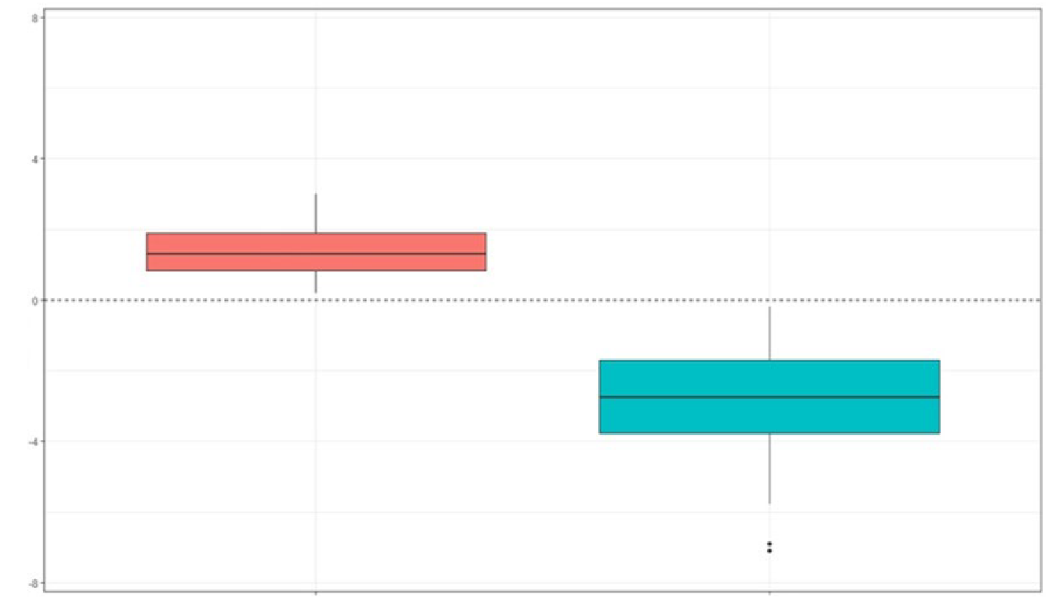
Figure 6. Boxplot of the maxillomandibular difference in the control group and in the study group. The red bloxplot is the control group and the green bloxplot is the pathology group. After analyzing the maxillomandibular difference between sexes, boys and girls,